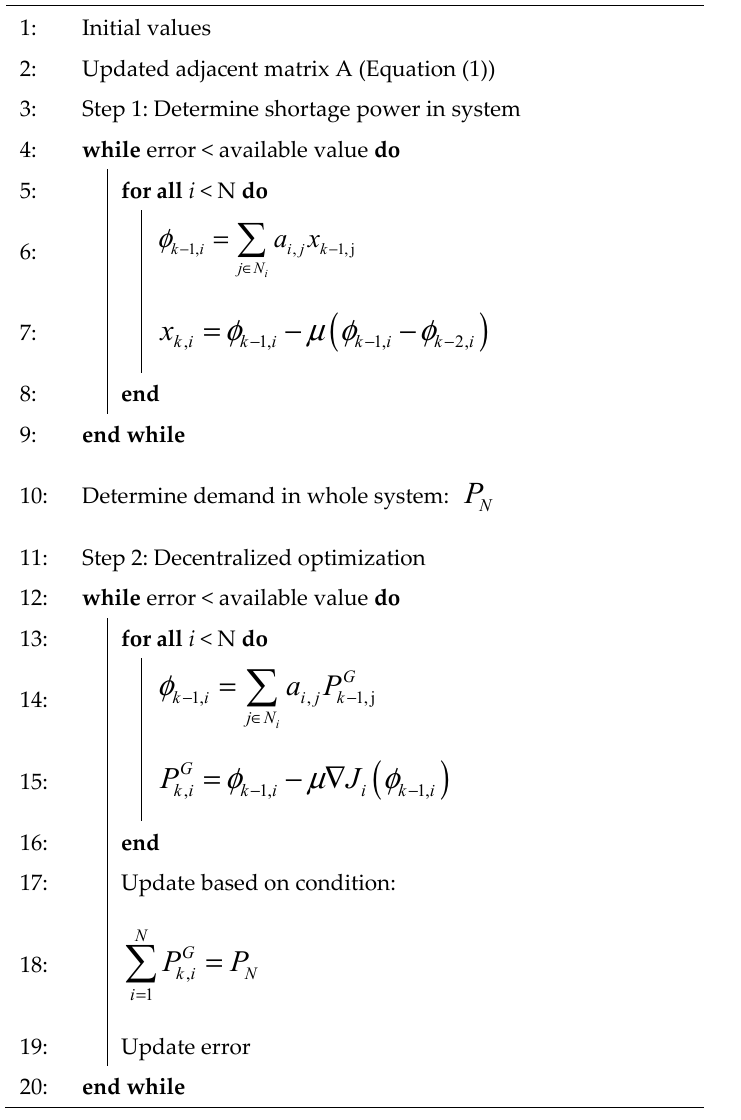
Algorithm 1 Diffusion strategy for distributed